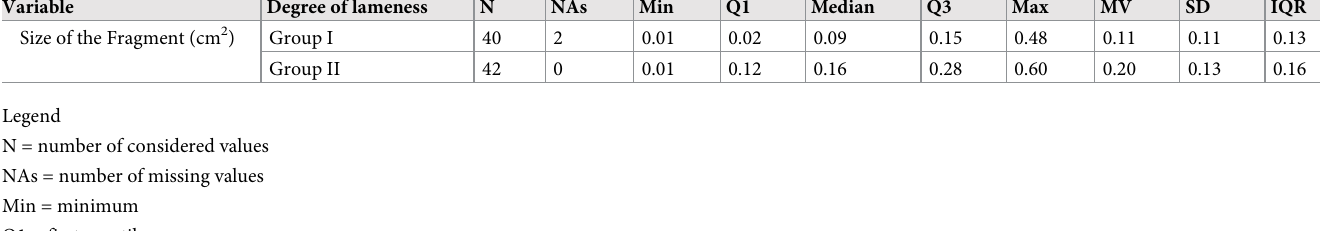
Discussion This is currently the only study which analyses the disease pattern of MCD comparatively showing two different clinical pictures in one dog. Comparing to other studies, the median age of 36.7 (SD: 31.1) months of dogs at diagnosis was above the average and the median weight of 33.6kg (SD: 10.5) was similar to other studies [25, 27, 28]. Crossbreed dogs, Labrador Retriev- ers and male dogs were over-represented which is mirrored in other studies [25, 27, 28, 38]. The aim of the current study was to evaluate whether there are different radiographic or CT imaging findings which can explain a clinically unilateral lameness despite bilateral diagnosed MCD. The IEWG score was higher by 31% on the side of the lameness compared to the non- lame limb. However, it should be noted that both limbs had at least in 50% of cases a modified IEWG Score of 0 (57.1% vs. 52.4%). TNS values were only slightly deviated by 0.021 (0.460 group I vs. 0.481 group II), which seems to make it a worse clinical criteria to guide therapy. CT imaging might provide a better way to differentiate the two groups. A dislocated frag- ment, diagnosed in 59.5% of the forelimbs showing a lameness (group II), can cause lucent defects in the subchondral bone and explain pain and lameness [39]. Table 7. Size of the fragment classified by degree of lameness: Group I + II. Variable Degree of lameness N NAs Size of the Fragment (cm 2